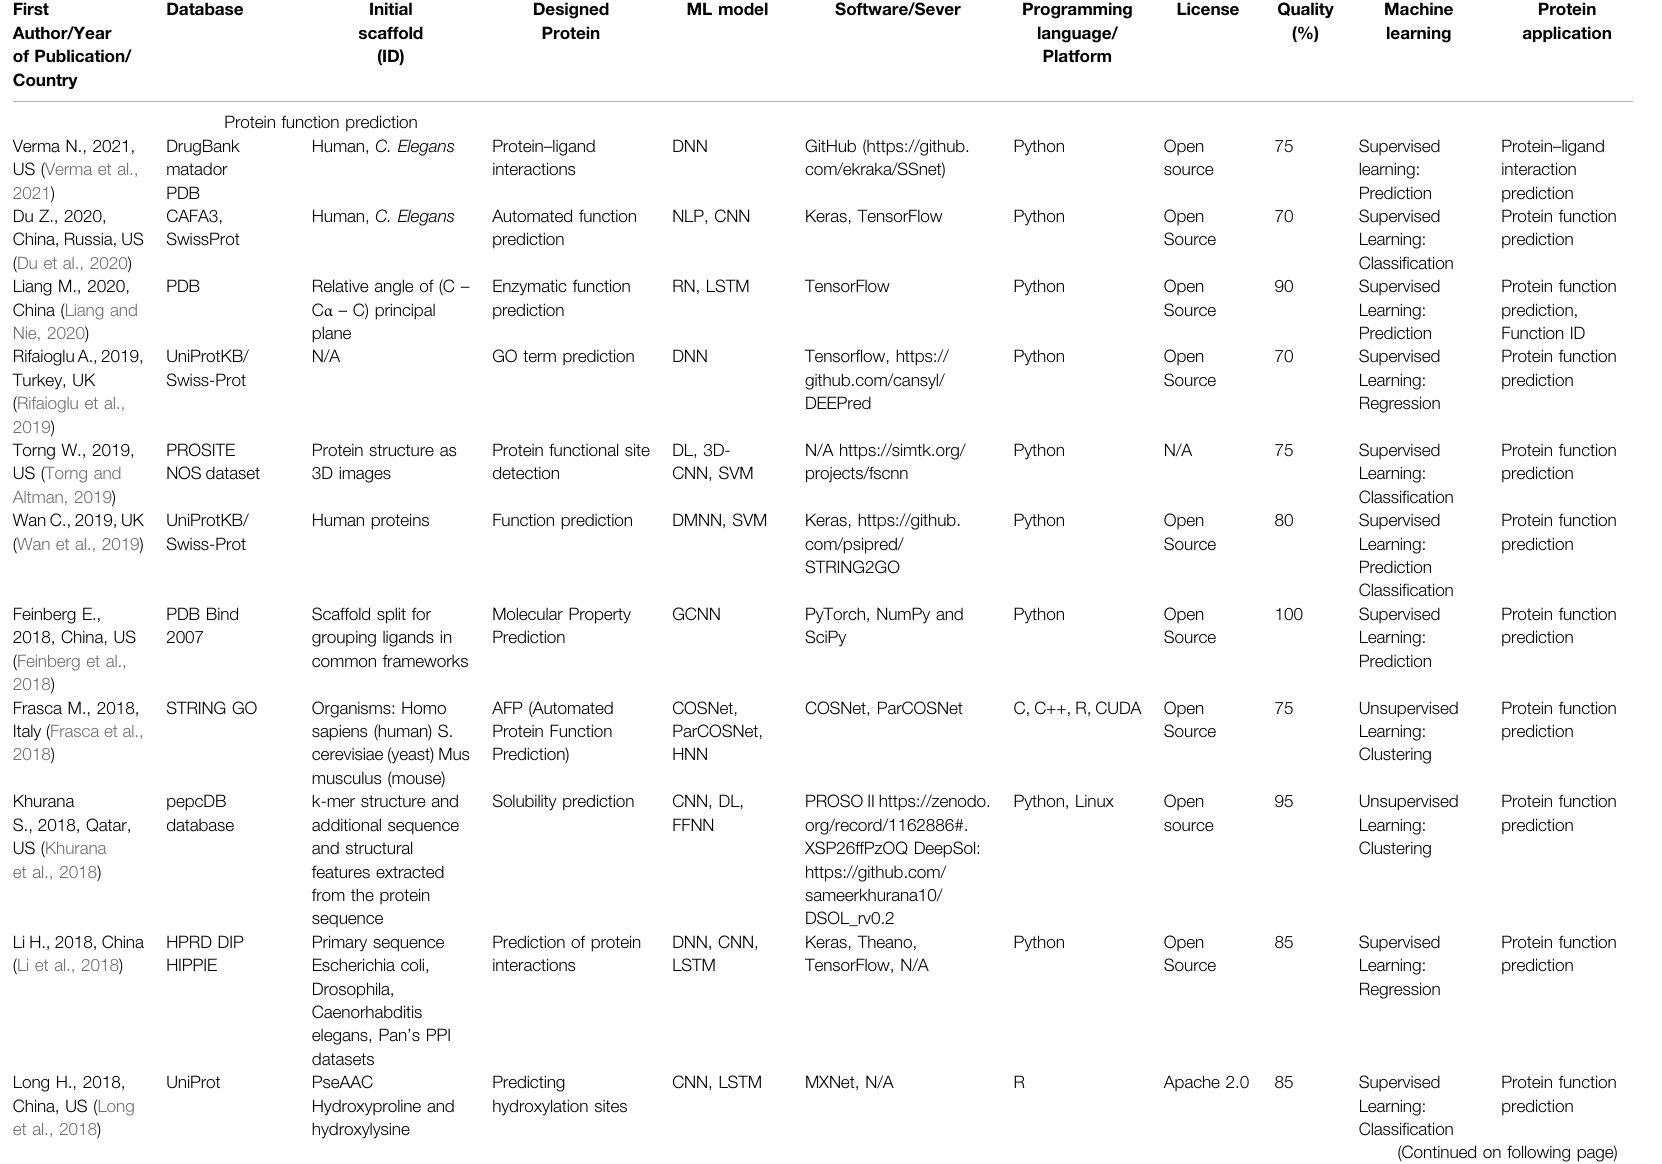
TABLE 3 | An overview of the protein function prediction, function prediction, and novel function articles with the quality